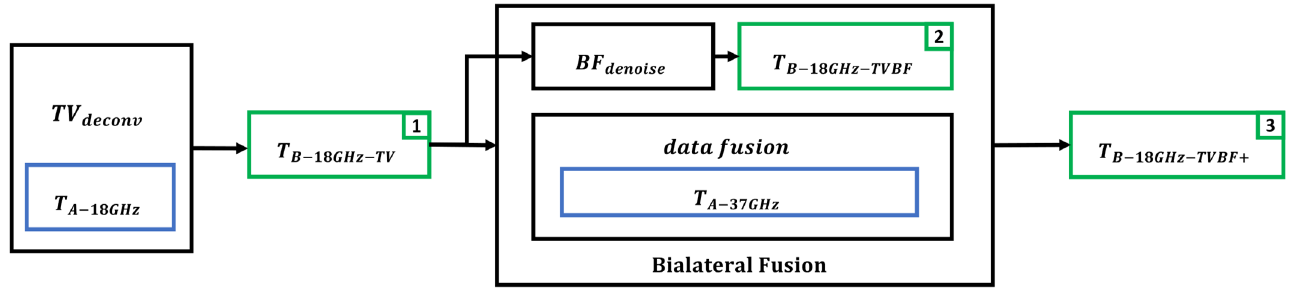
Figure 3. The flowchart of the proposed method. (The blue blocks denote the observations collected by MWRI. The green blocks denote the output of the proposed methods and the number in the upper right corner of the green blocks denotes the level of the restoration).